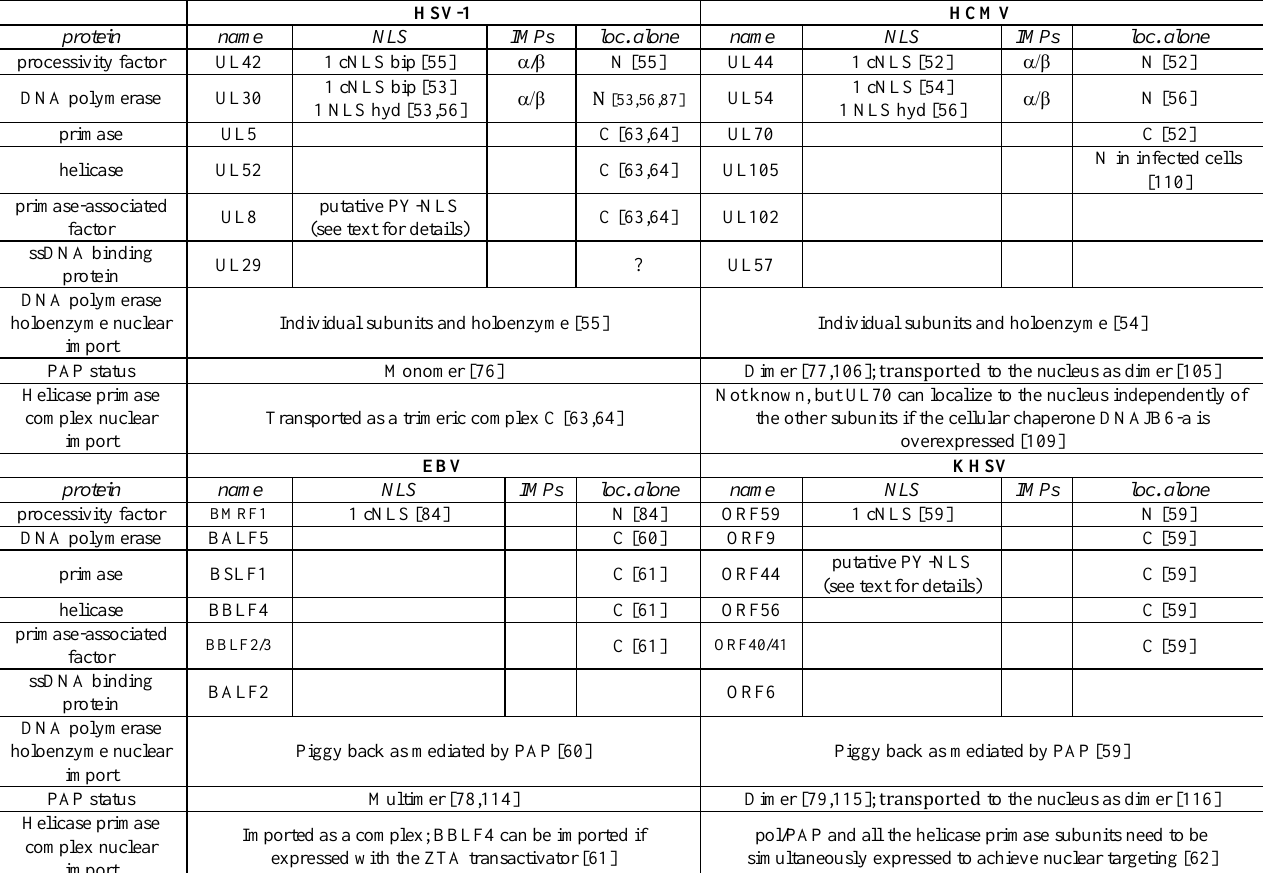
Table 1. Identified NLSs and nuclear import pathways of Herpesviral DNA replicating enzymes. The NLSs identified so far for each herpesviral DNA replication proteins are indicated, as well as the IMPs binding them. The subcellular localization of each protein when individually expressed is also indicated (loc. alone). Additional details are reported in respect to the nuclear import pathways of DNA polymerase and helicase/primase holoenzymes. Pol, DNA polymerase catalytic subunit; PAP, DNA polymerase processivity factor: hNLS, hydrophobic NLS; cNLS, classical NLS; bip, bipartite NLS; N, nucleus; C, cytoplasm; IMPs, importins.